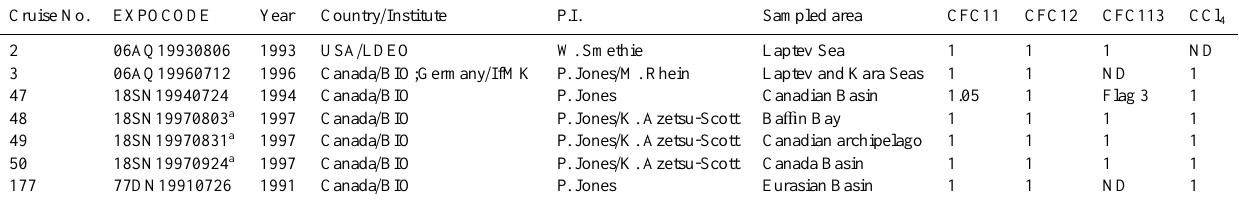
Table 2. CARINA cruises with CFC data in the Arctic Ocean. ND denotes “no data”, i.e. the parameter was not measured; Adjustments for the CFCs are multiplicative. Flag 3 means that the data are of questionable quality and are not included in the merged data product. Cruise No.